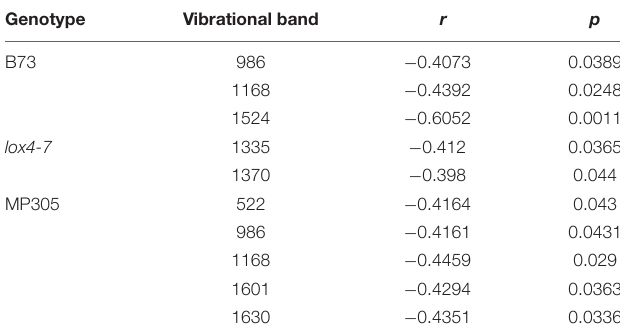
TABLE 8 | Vibrational bands that can be used to determine sizes of lesions in the field-grown B73, lox4-7 , and MP305 with corresponding r and p